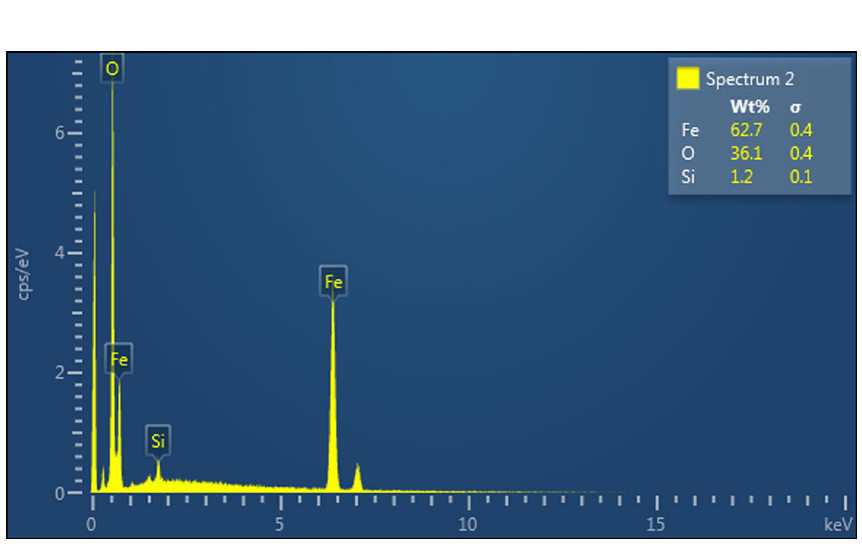
Fig. 1 SEM micrograph of magnetite nanoparticles at a magnification of (50,000 X) and at 15 kV